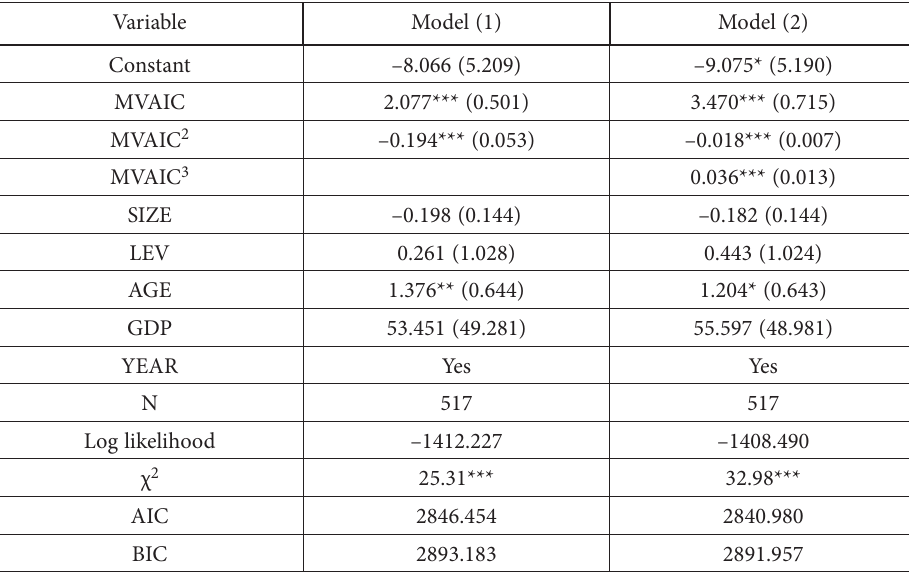
Table 8. Empirical results of Models (1) and